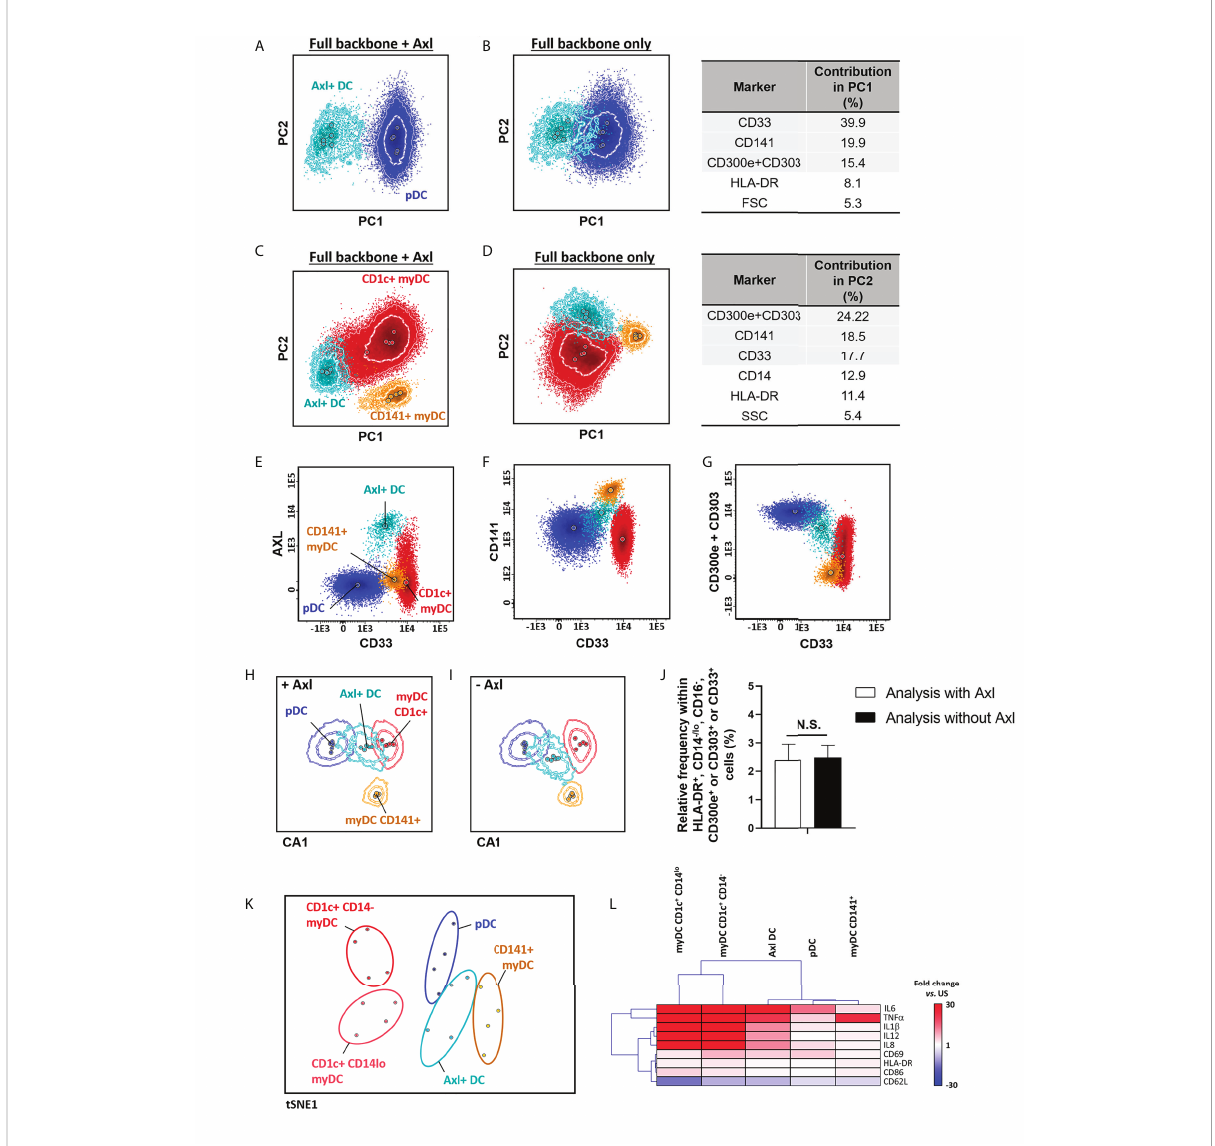
FIGURE 3 Identi fi cation and functional characterization of Axl + dendritic cells (DCs) vs. other DC populations. Identi fi cation of Axl + DCs within the HLA- DR + CD14 -/lo , CD16 - , CD300e + or CD303 + or CD33 + cell population vs. plasmacytoid (A, B) and myeloid (C, D) DCs, in the context of staining with CD1c, CD14, CD16, CD33, CD45, CD141, CD300e+CD303 (i.e. full backbone) alone (B, D) or in combination with Axl (A, C) (n=5) is shown. Performance of the full backbone for discrimination of Axl + DCs vs. other DCs, and the relative contribution of the most informative markers (>5%) for the separation between populations is depicted in (B, D) . Expression patterns of the minimum set of markers required for identi fi cation of Axl+ DCs are shown in panels (E – G) , respectively. (H, I) represent the canonical multivariate analysis (CA) for overall discrimination of DC populations (n=5 donors). Relative frequency of Axl + DCs after staining with CD33, CD141 and CD300e+CD303 with and without Axl, is depicted in (J) (n=5). The t-distributed stochastic neighbor embedding (t-SNE) plot in (K) depicts the overall expression of activation- and maturation-related markers which showed statistically signi fi cantly different expression patterns at steady-state and in response to stimulation with LPS (TNF a , IL1 b , IL6, IL8, IL12, CD33, CD62L, CD63, CD69, CD83, CD86 and HLA-DR) between the distinct DC populations (n=4 donors). (L) shows a hierarchical clustering analysis of the response to stimulation with LPS (given as fold change vs. steady-state) of the distinct DC populations identi fi ed employing the backbone set of markers. Statistical differences were evaluated employing Kruskall-Wallis and Wilcoxon tests with a false discovery rate (FDR) of 5% to correct for multiple comparisons, to compare between populations and steady-state vs. stimulation, respectively. Solid circles in all principal component, canonical analysis and tSNE plots represent median values for the parameters evaluated, inner dotted and outer solid lines depict the fi rst standard and second standard deviations for each population identi fi ed. pDC, plasmacytoid dendritic cells; myDC, myeloid dendritic cells; PC, principal component; CA, canonical multivariate analysis; N.S., not statistically signi fi cant (p value>0.05); tSNE, t-distributed stochastic neighbor embedding; US,